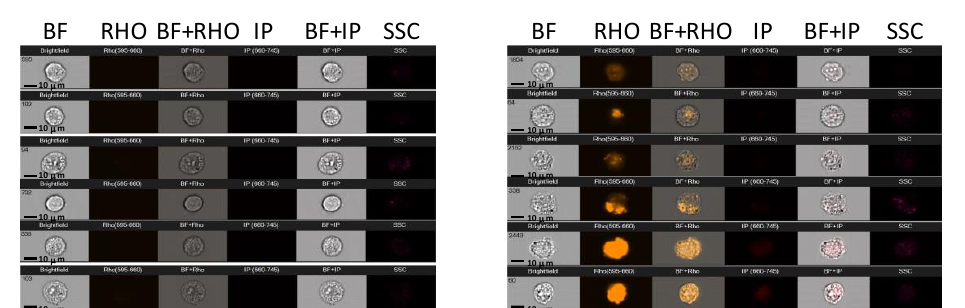
Figure 8. Examples of AMNIS cytometer cell images. Huh 5-2 cells treated with (NH 3+ ) 8 [GMPA]-[MPA](C17) 4 ( left ) (NH 3+ ) 8 [GMPA]-[MPA](C17) 4 /RhB(C17) 2 ( right ). Each column collects images taken under di ff erent light sources. BF (brightfield), Rho (Rhodamine fluorescence was measured by exciting at 488 nm and detecting emission at 529 nm using AMNIS cytometer); IP (Propidium iodide was excited using a laser that emits at 488 nm and emitted fluorescence was detected at 660 nm in another channel to avoid emission fluorescence overlap rhodamine); SSC (side scattered